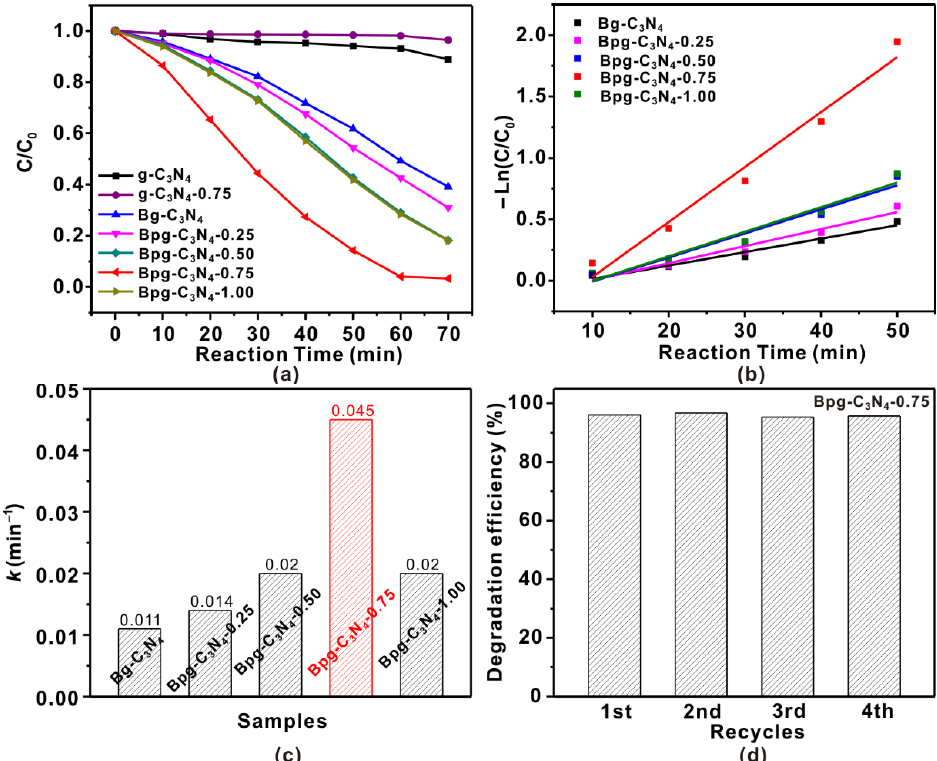
Figure 7. ( a ) Photodegradation of RhB (15 mg·L − 1 ) under visible-light irradiation ( λ ≥ 420 nm); ( b ) pseudo-first-order kinetic linear simulation lines; ( c ) the corresponding pseudo-first-order kinetic constants ( k ); ( d ) RhB degradation efficiency within 70 min of visible-light irradiation for four consecutive runs.